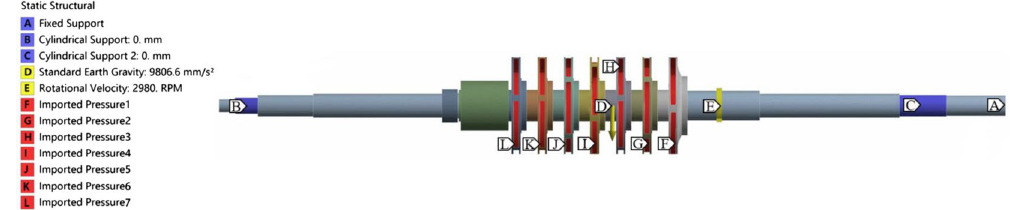
Figure 4. Loads and restraints for the centrifugal pump rotor.